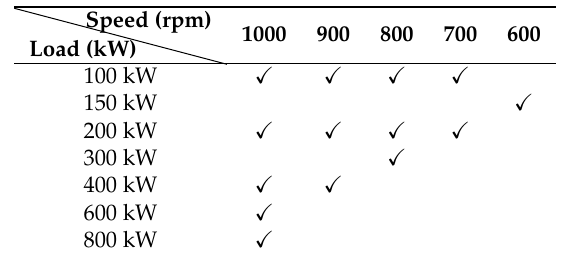
Table 4. Selection of operating